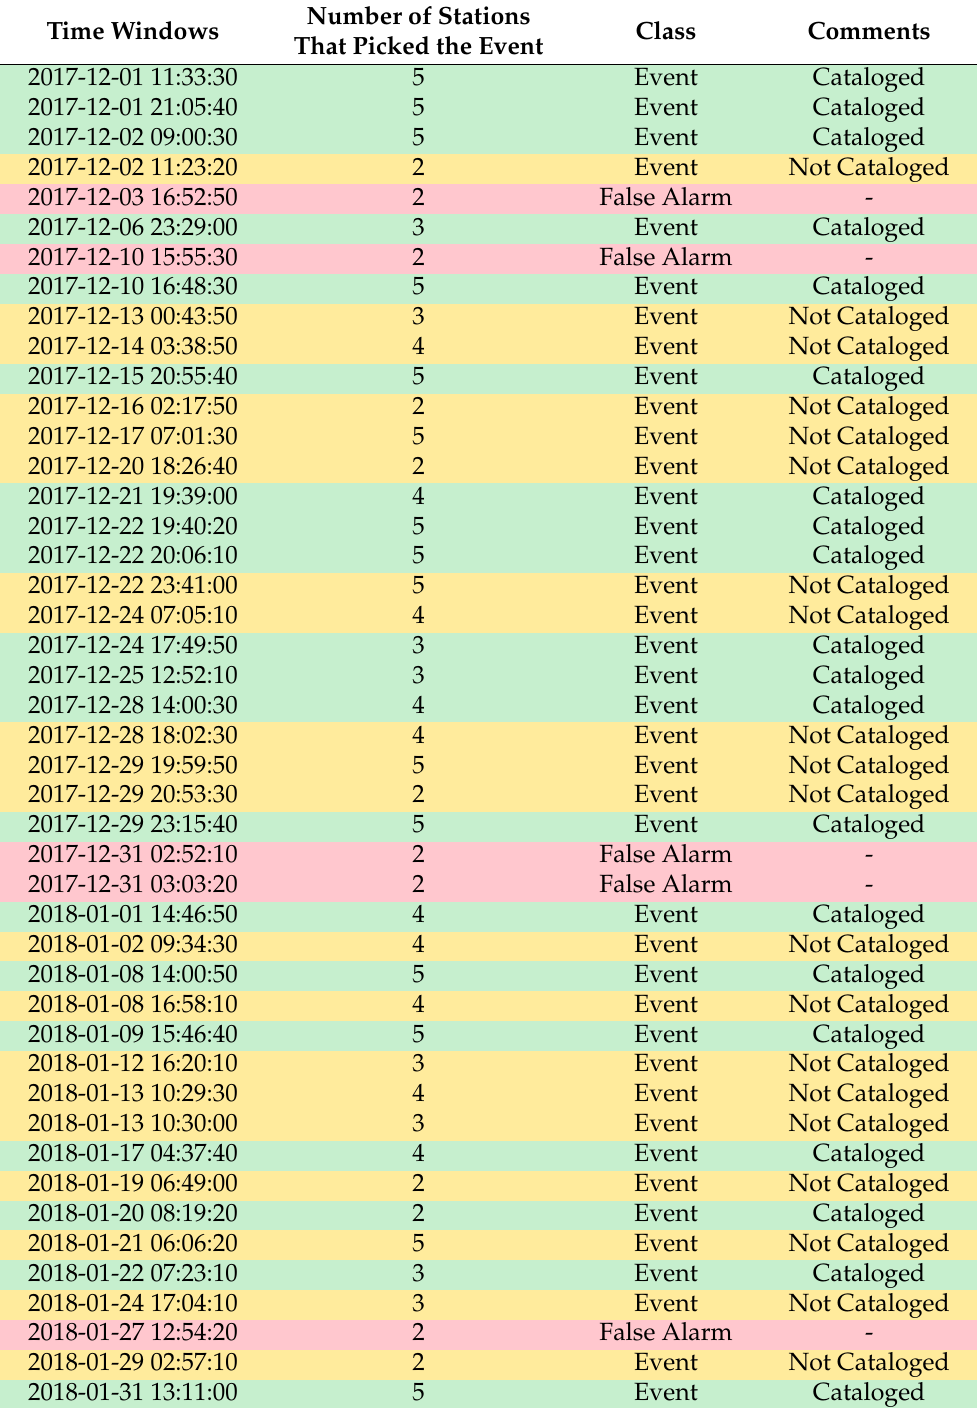
Table 2. CNN detections with cataloged events highlighted in green color, uncataloged in yellow, and false alarms in